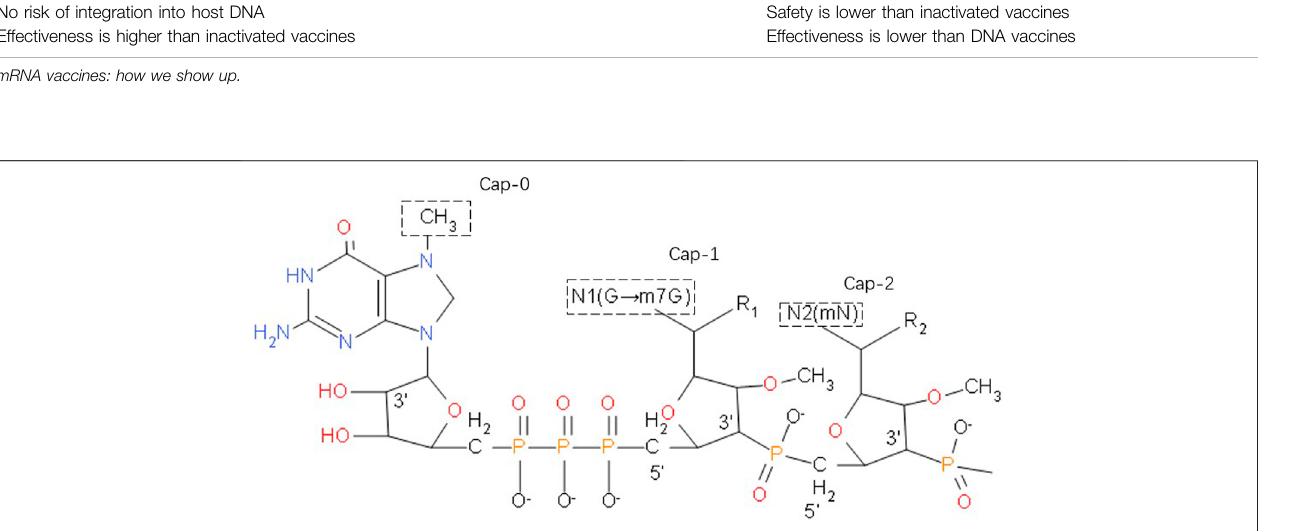
base sugar chain is also methylated, which is